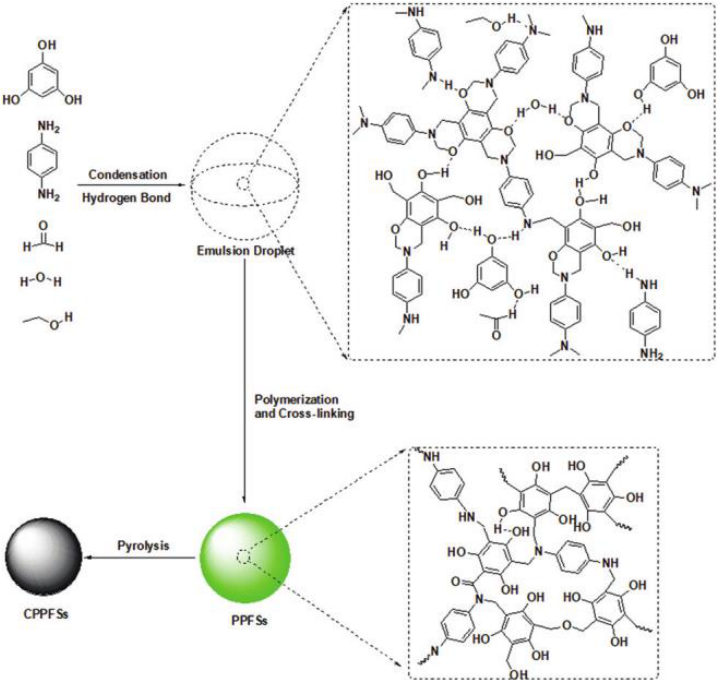
Figure 19. Catalyzed ring opening polymerization and carbonizations to form carbon nanospheres (reproduced from the work in [66] with permission).